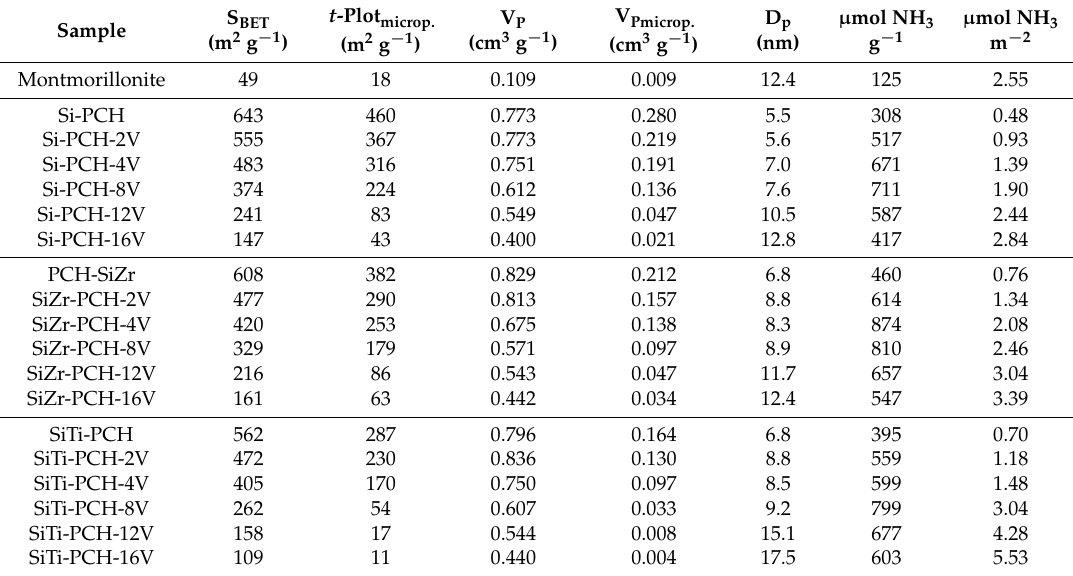
Table 1. Textural and acid parameters of the starting montmorillonite, support and catalysts.